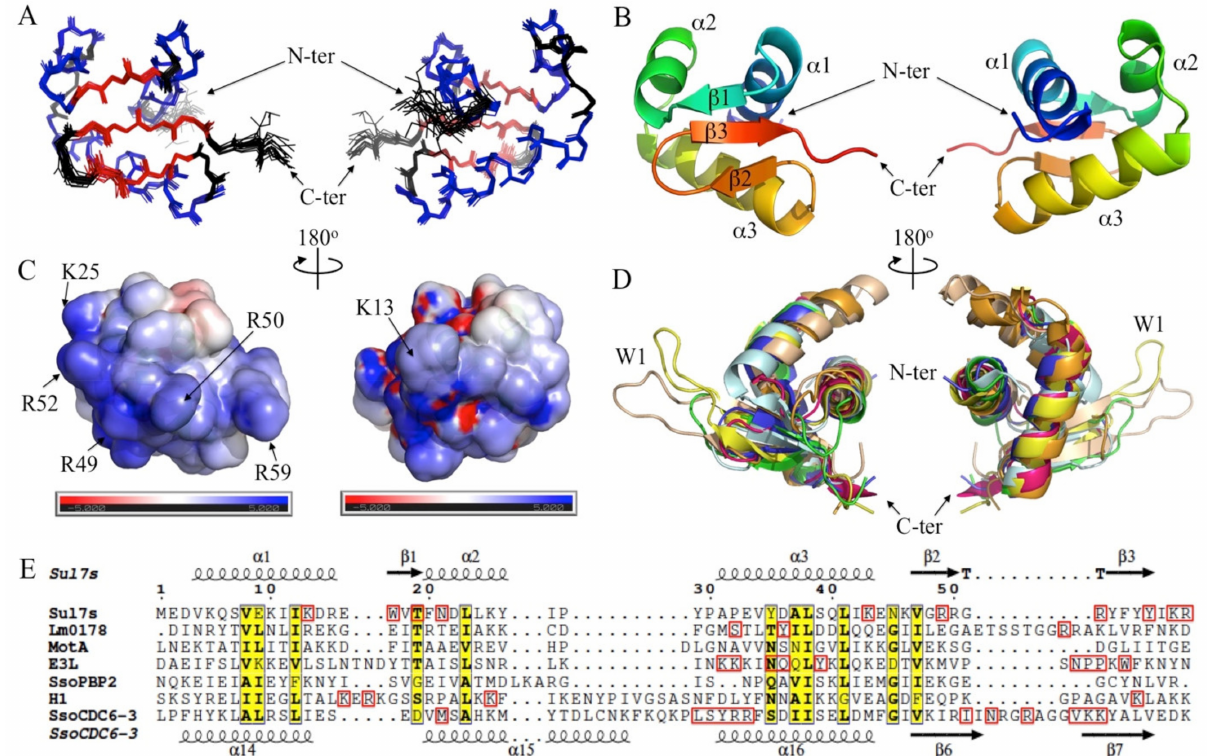
Figure 4. Overall solution structure of S. islandicus Sul7s. ( A ) Ribbon representation of the 20 lowest- energy solution structures of Sul7s. The backbone of α -helices, β -strands, and random coils are shown in blue, red, and black, respectively. ( B ) Cartoon representation of Sul7s. ( C ) Molecular surface of Sul7s colored by electrostatic potential. Blue, positively charged; red, negatively charged; white, neutral. Some positively charged residues on the molecular surface are labeled. ( D ) Superposition of Sul7s (in blue) with Lmo0178 from L. monocytogenes (in yellow, PDB code: 5F7P), bacteriophage T4 DNA-directed RNA polymerase subunit MotA (in pink, PDB code: 6K4Y) [34], the Z-DNA-binding domain of E3L from Yatapoxvirus (in green, PDB code: 1SFU), PBP2 from S. solfataricus (in pale cyan, PDB code: 5N35), the globular domain I of yeast Histone H1 (in orange, PDB code: 1UST) and CDC6-3/Orc1-3 from S. solfataricus (in wheat, PDB code: 2QBY). ( E ) Structure based sequence alignment of the proteins shown in ( D ). The residues contacting DNA for each protein are indicated by red